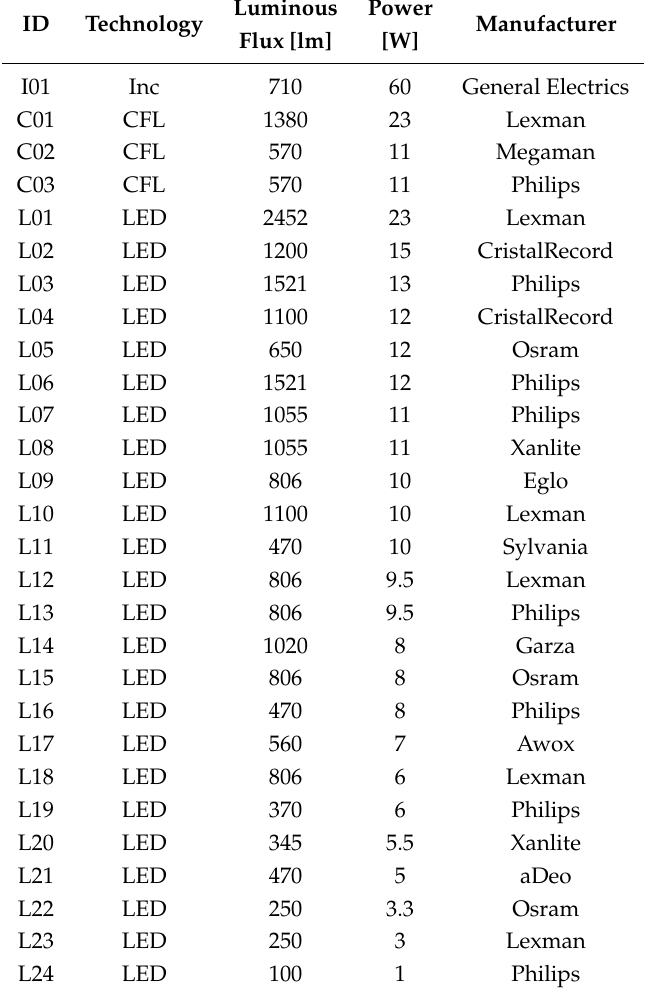
Table 1. Set of lamps under